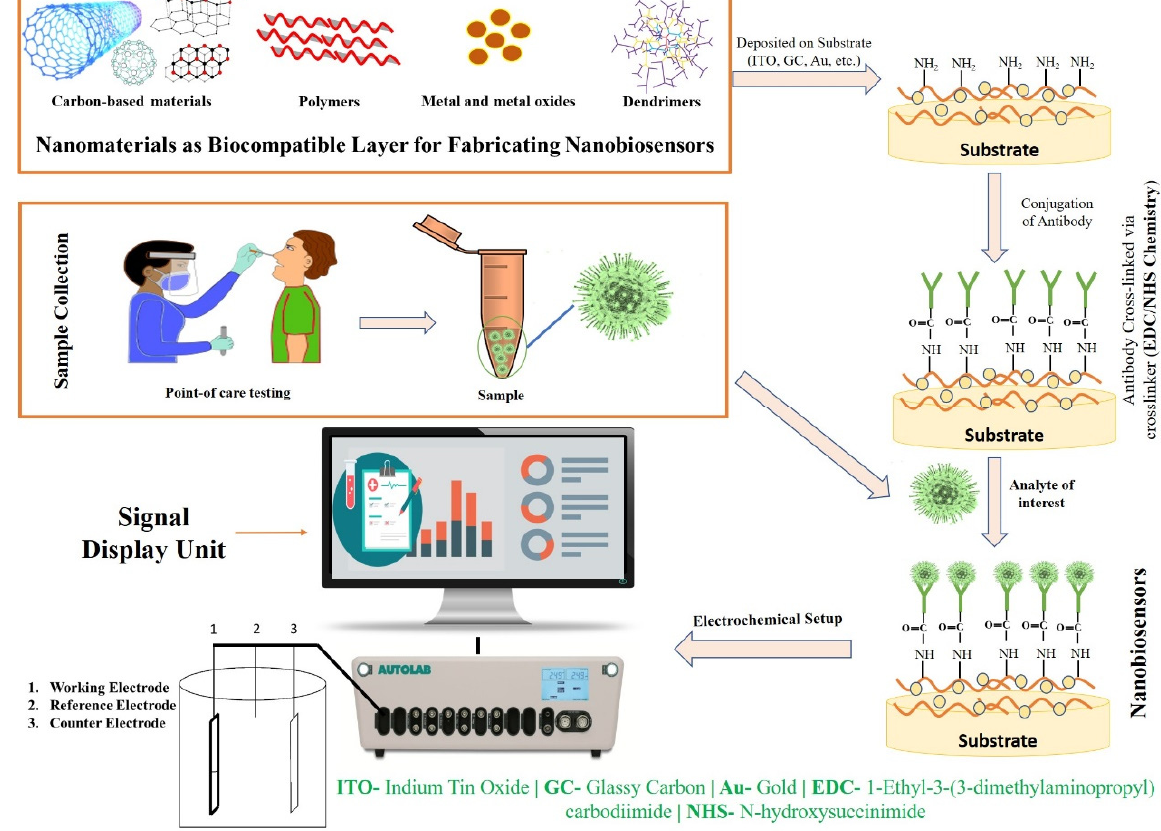
Figure 2. Fabrication strategy and working mechanism of nanobiosensors.